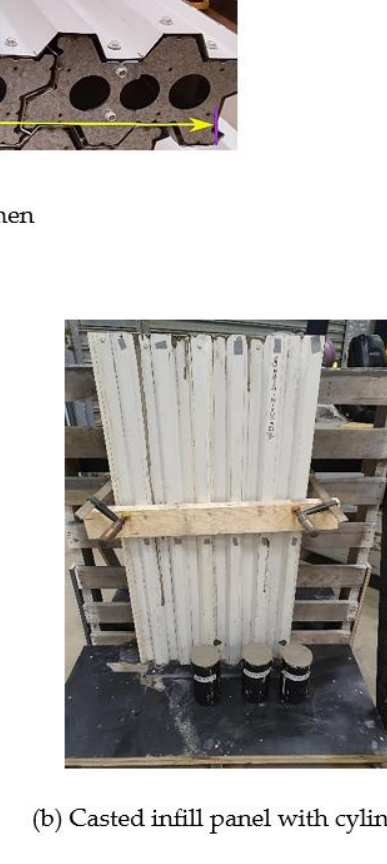
Figure 2. Specimen types.